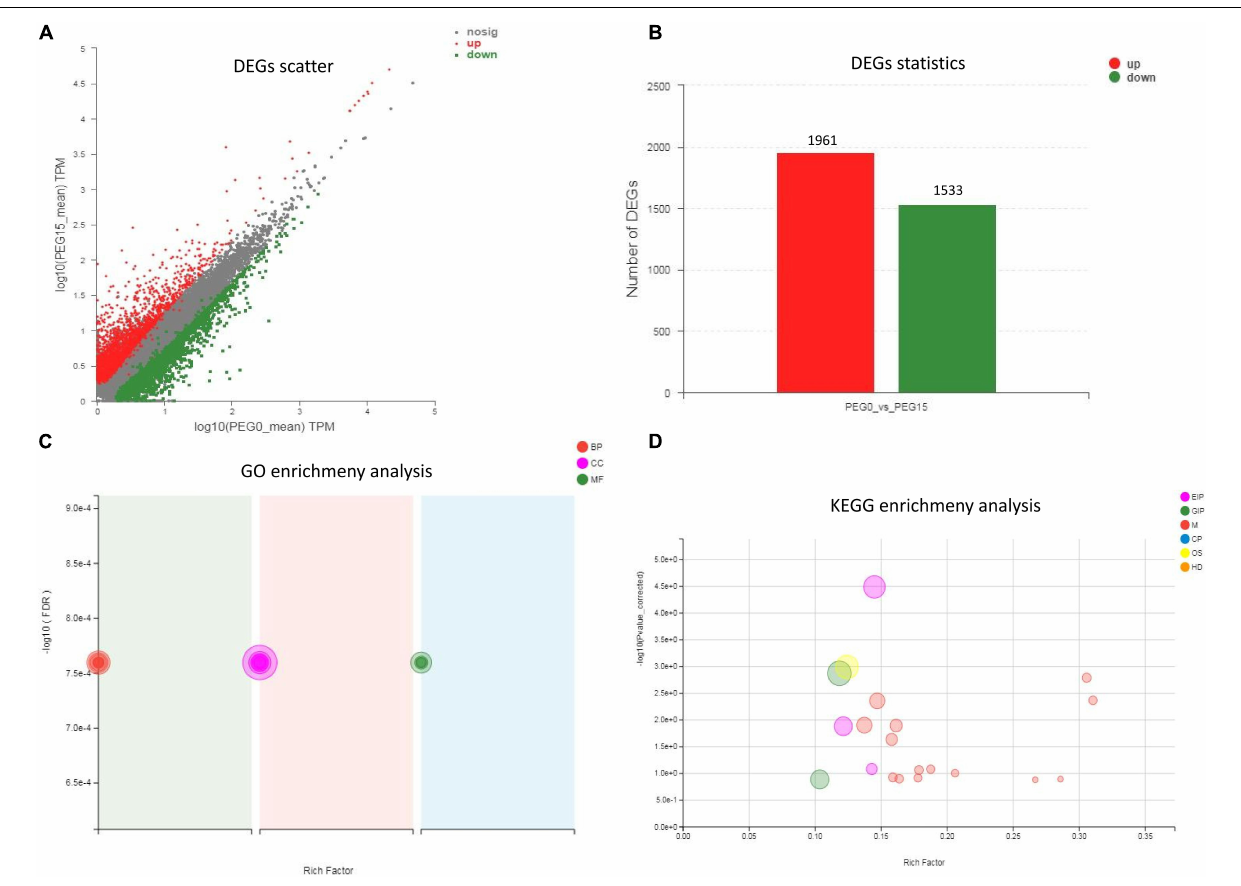
FIGURE 6 | Differentially expressed genes (DEGs) statistics and functional enrichment analysis. (A) DEGs scatter analysis; (B) DEGs statistical analysis; (C) Gene Ontology (GO) enrichment analysis; (D) Kyoto Encyclopedia of Genes and Genomes (KEGG) enrichment analysis.